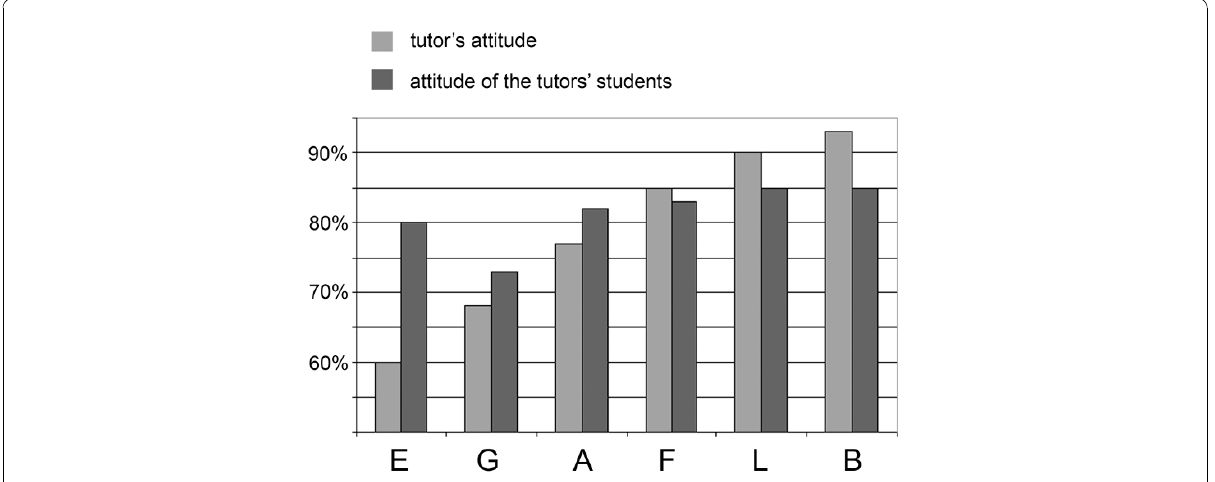
Figure 5 Tutors ’ and students ’ attitude towards digital applications in education . Capitals (E, G, A, F, L, B) represent the 6 tutors where more than 10 student filled the questionnaire. Responding students n = 16(E), 12(G), 18(A), 16(F), 11(L),